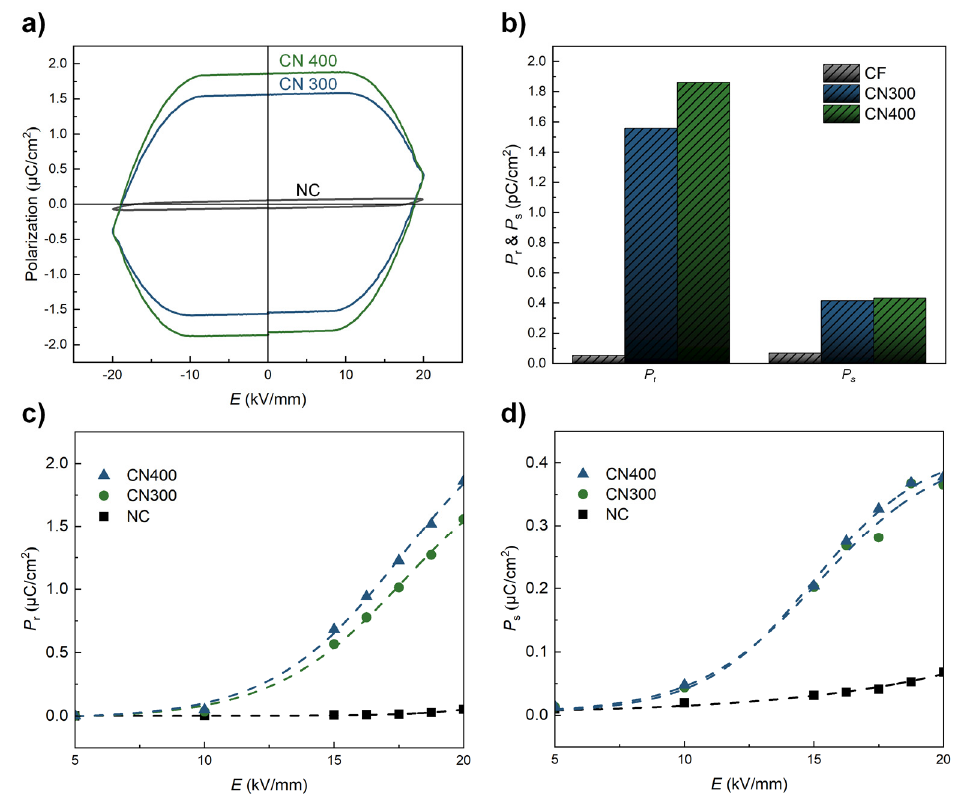
Figure 9. ( a ) P − E curves of NC, CN300, and CN400 in the range of ± 20 kV/mm. ( b ) P r and P s plots of NC, CN300, and CN400 under a maximum electric field of 20 kV/mm. ( c , d ) P r and P s of each sample as a function of the applied electric field.